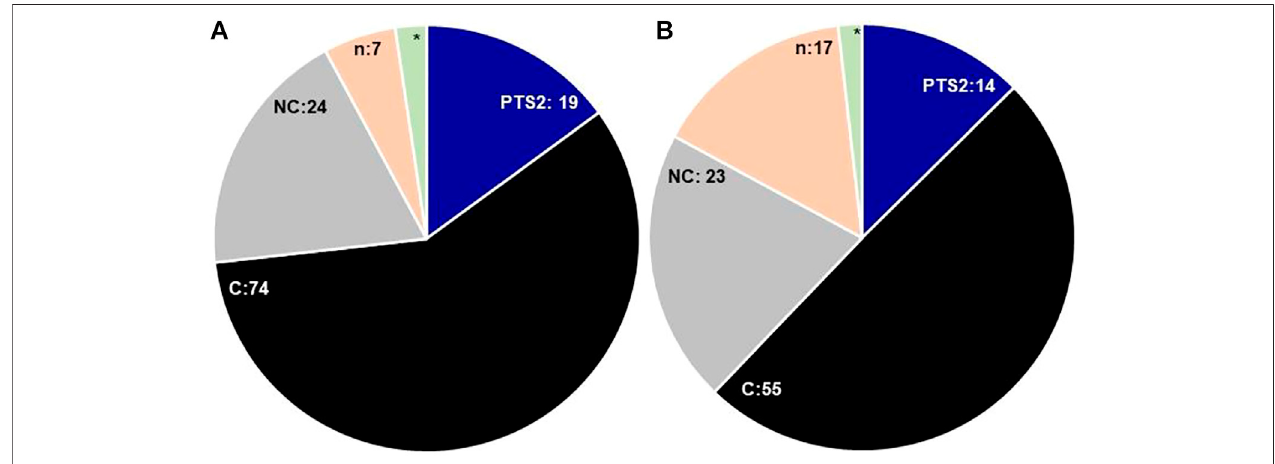
FIGURE 2 | Comparative snapshot of Arabidopsis thaliana (A) and Solanum lycopersicum (B) peroxisomal proteome: the fi gure shows the comparative numbers ofproteins/putative proteins present in each category; PTS1 — peroxisomal targetingsignal type 1[C — canonical, NC — non-canonical],n — no obviousPTS, *-catalase containing internal PTS; PTS2: peroxisomal targeting signal type 2. The digits denote the respective numbers of proteins/putative proteins present in each category, * = 3 in Arabidopsis thaliana , 2 = Solanum lycopersicum .